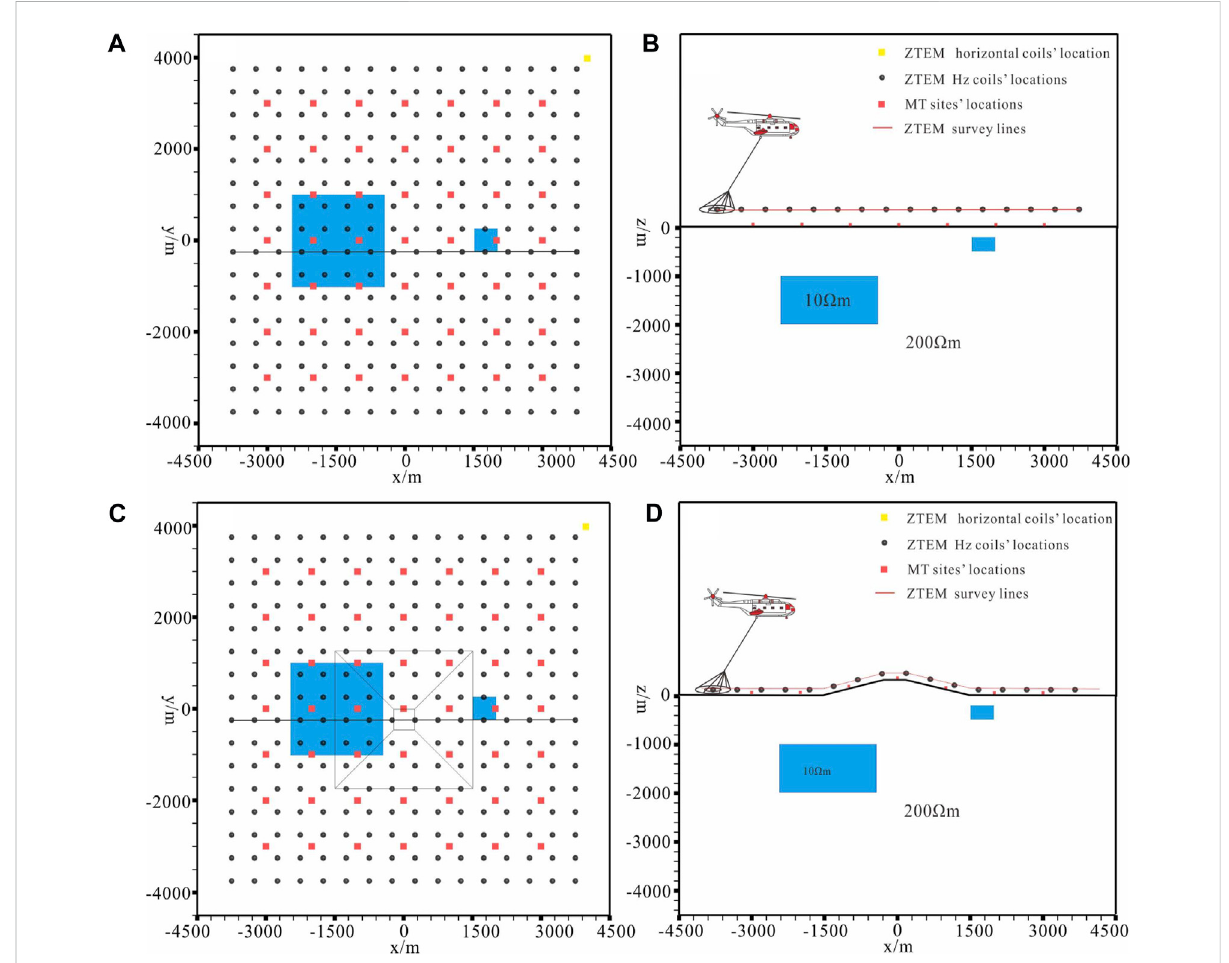
FIGURE 1 Surveygridsforthesyntheticmodels. (A) Syntheticmodelwithouttopographyon xy plane; (B) syntheticmodelwithouttopographyon yz plane; (C) synthetic model with topography on xy plane; (D) synthetic model with topography on yz plane. The three grids are MT sites (red squares), ZTEM sites (black circles), and ZTEM base site (yellow